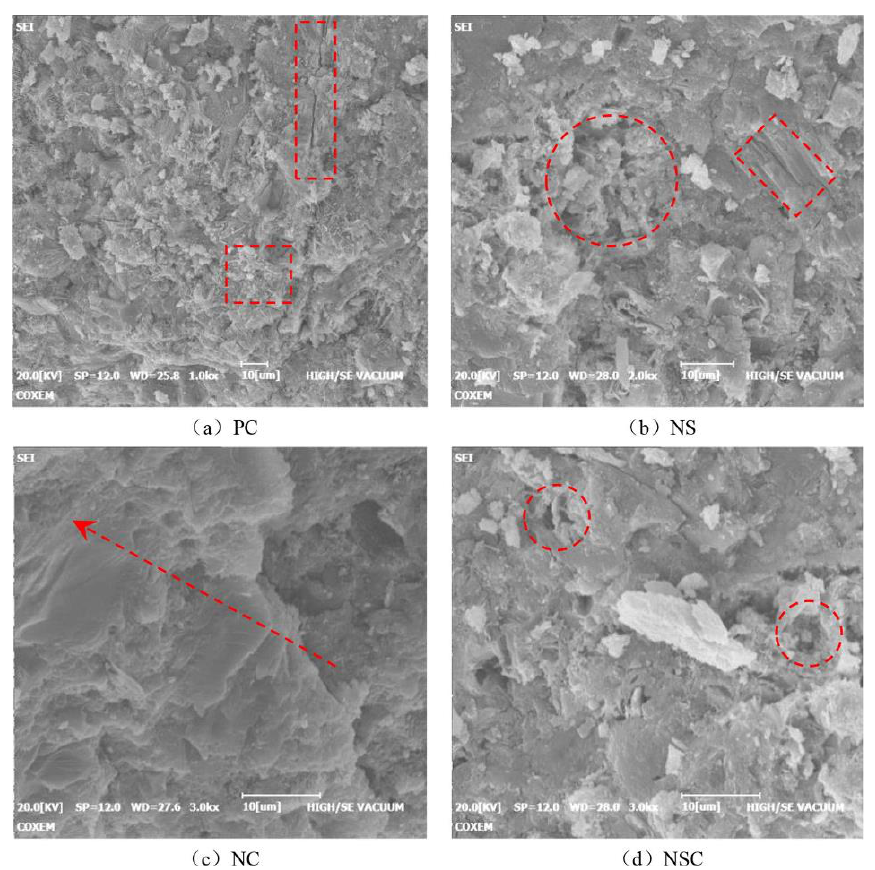
Figure 4. Micrographs of different additions of NC and NS [50]. Guler, Türkmeno˘glu et al. [31] analysed the SEM microstructure at high temperatures. The NS-doped and nano-Al2O3(NA) were heated to 300 ◦ C, 500 ◦ C and 800 ◦ C. After heating at 300 ◦ C, the internal microstructure deteriorated but still retained the compressive strength; at 800 ◦ C the internal structure was largely destroyed, and the greatest loss of strength was observed. Many microscopic cracks and increased voids appeared inside the concrete after heating at 500 ◦ C, as shown in Figure 5. The addition of nanomaterials at 0.5%, 1.0% and 1.5% all significantly improved the microstructure of the concrete matrix and enhanced cement paste bonding and reaction, with equivalent strength at